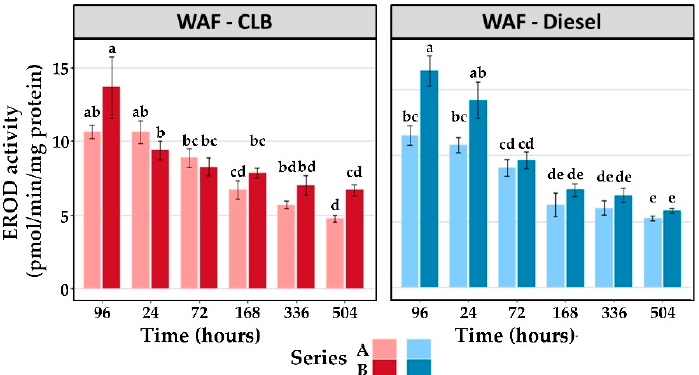
Figure 9. EROD activity in lobster hemolymph for WAF-CLB and WAF-Diesel treatments during the recovery period in series A and B. Mean ± SE; n = 3. The letter symbols indicate a significant (p < 0.05) effect between time and series.